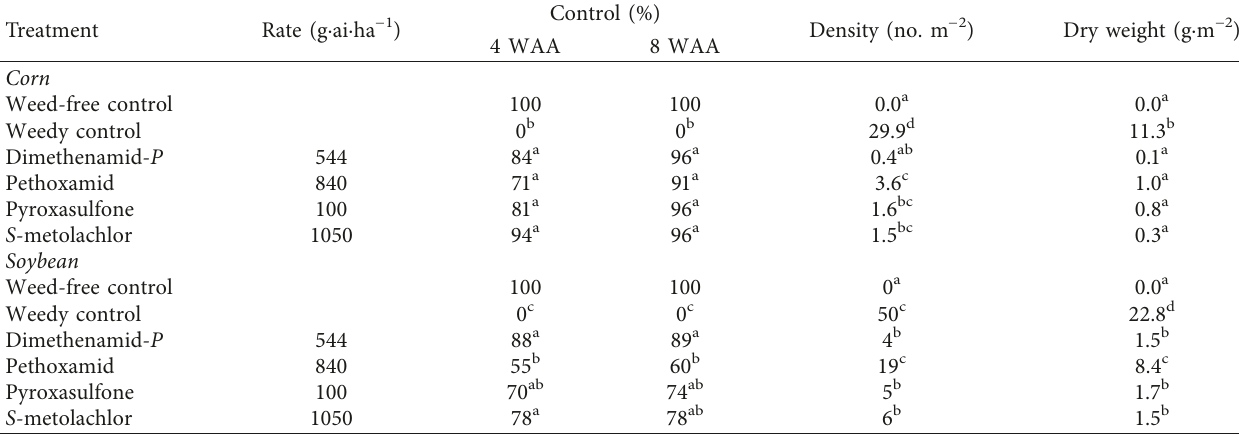
Table 6: Control, density, and dry weight of green foxtail in corn and soybean treated with VLCFA inhibitor herbicides, applied pre- emergence (PRE), near Exeter in 2015–2017 and Ridgetown in 2017 a .